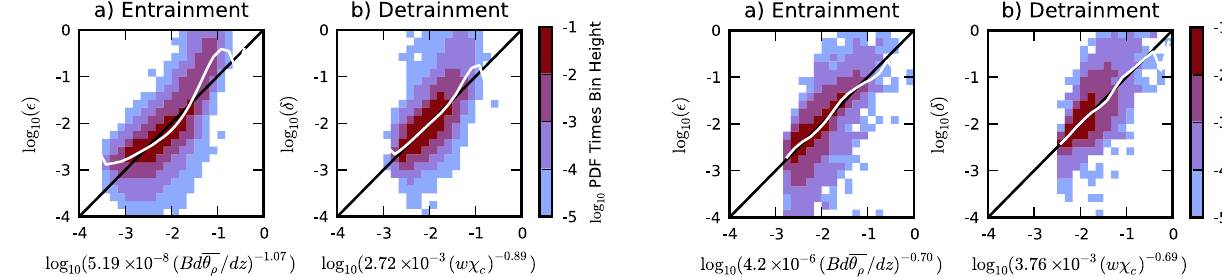
Fig. 13. Joint probability density functions multiplied by bin area ( P(x,y)1x1y ) for individual clouds in the combined BOMEX and ARM LES output between fractional mass entrainment/detrainment rates and best-fit entrainment/detrainment rates as predicted by cloud core properties. (a) log 10 ((cid:15)) versus the best-fit (cid:15)(B, d θ ρ / d z) relationship. (b) log 10 (δ) versus the best-fit δ(w,χ c ) relationship. PDFs are plotted using a logarithmic scale. White lines indicate the mean log 10 ((cid:15)) or log 10 (δ) values as functions of the best-fit rela- tionship, and black lines show the log 10 ((cid:15)) or log 10 (δ) values pre- dicted by the best-fit relationship.